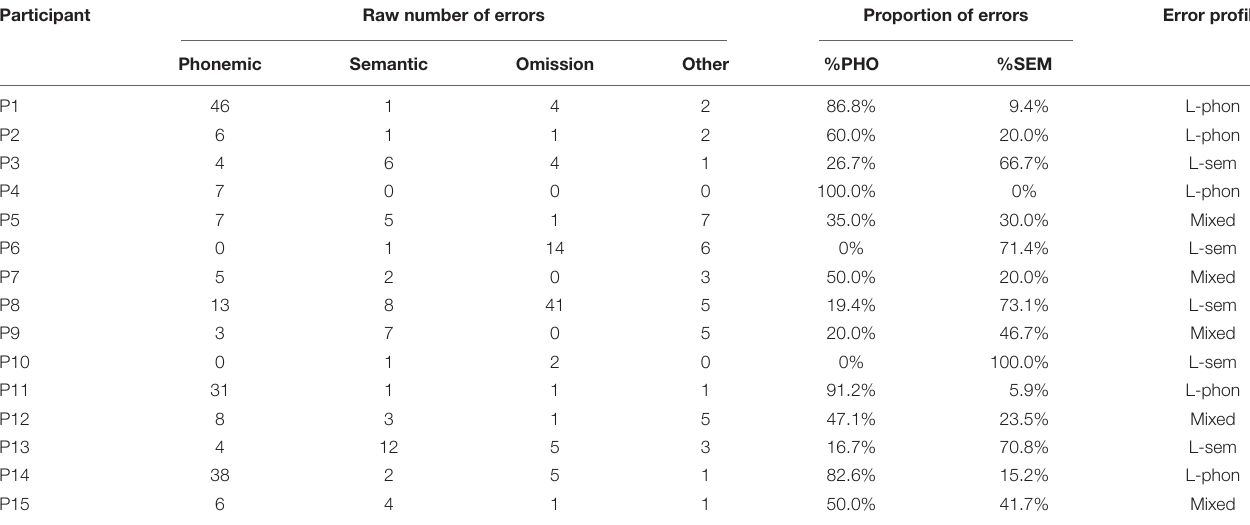
TABLE 2 | Amount and type of errors throughout the two paradigms and proportion of phonemic, semantic/omission errors in both paradigms for the 15 participants and subgroup assignment. Participant Raw number of errors